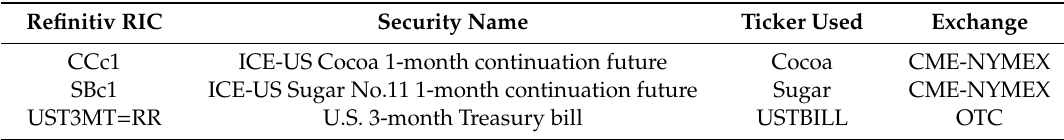
Source: Own elaboration with data from Refinitiv